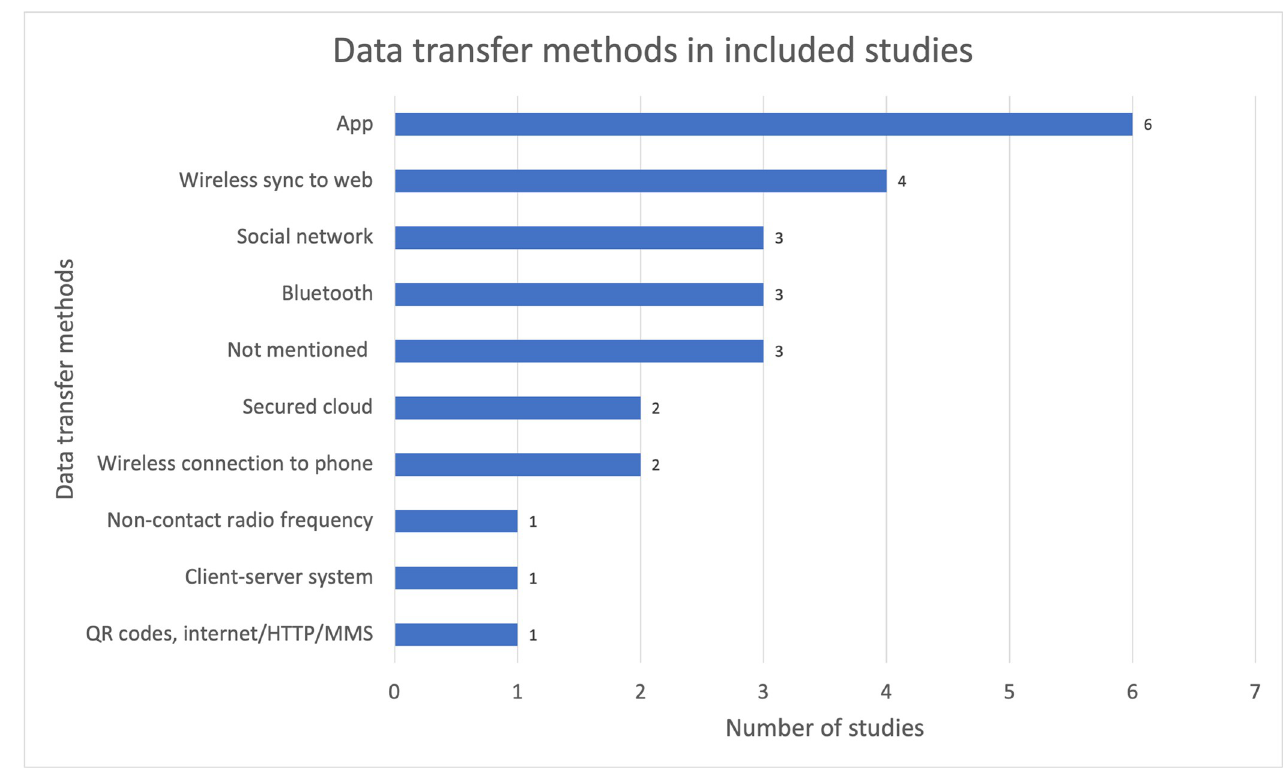
Fig 5. Data transfer methods in included